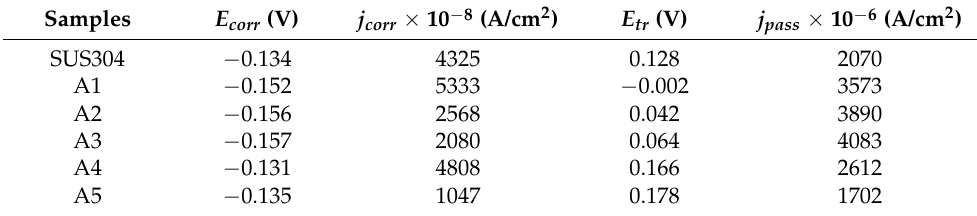
Table 3. Electrochemical parameters of A1, A2, A3, A4, A5, SUS304, and high-chromium cast iron in 3.5 wt % NaCl solution at room temperature.